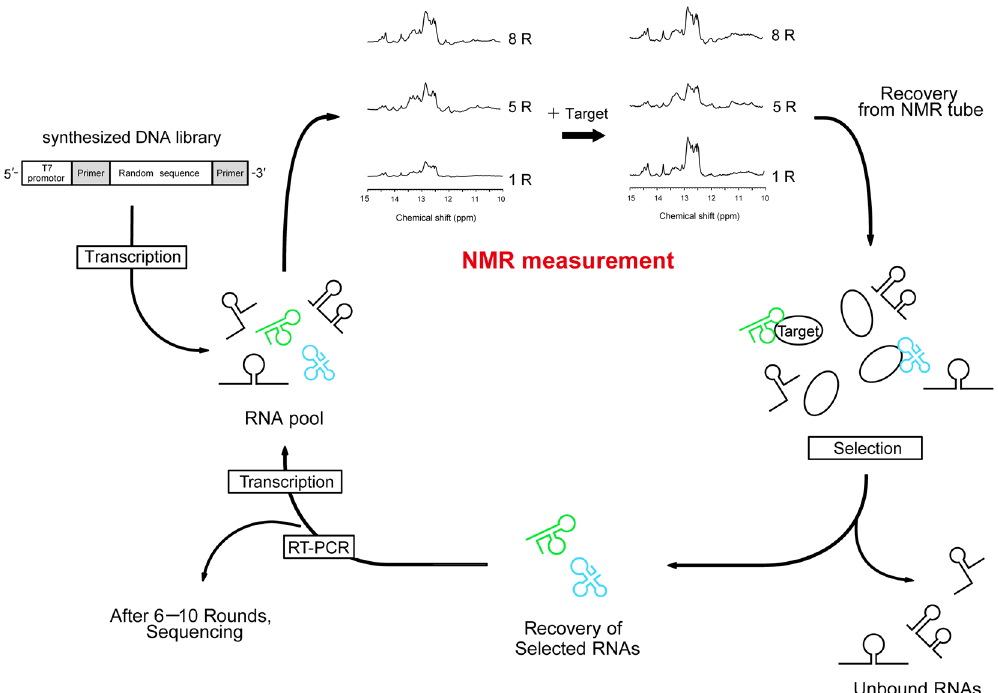
Figure 1. Schematic outline of NMR monitoring of the SELEX process. During each round of SELEX, imino proton signals of RNA pools and RNA binding to target proteins are monitored by NMR and then subjected to selection. Only 1 or 2 hours are required for measurement of the NMR spectra. The addition of target molecules can be